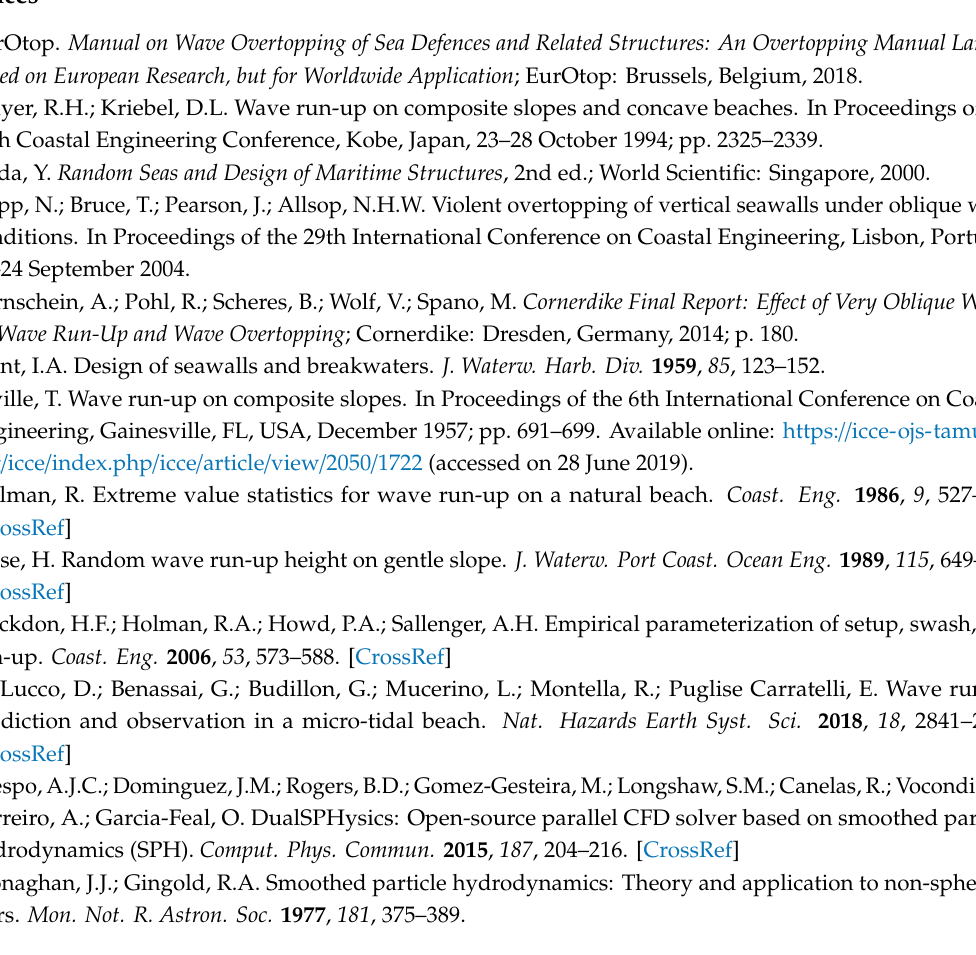
Figure A1. Run-up height calculation from 25 consecutive run-up events.